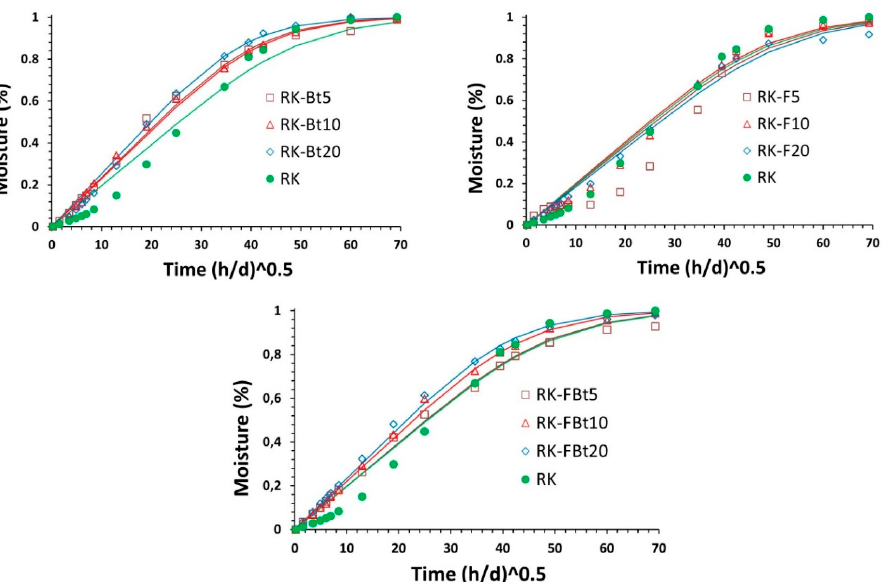
Figure 4. Simulation of the absorption curves by Fickian model.